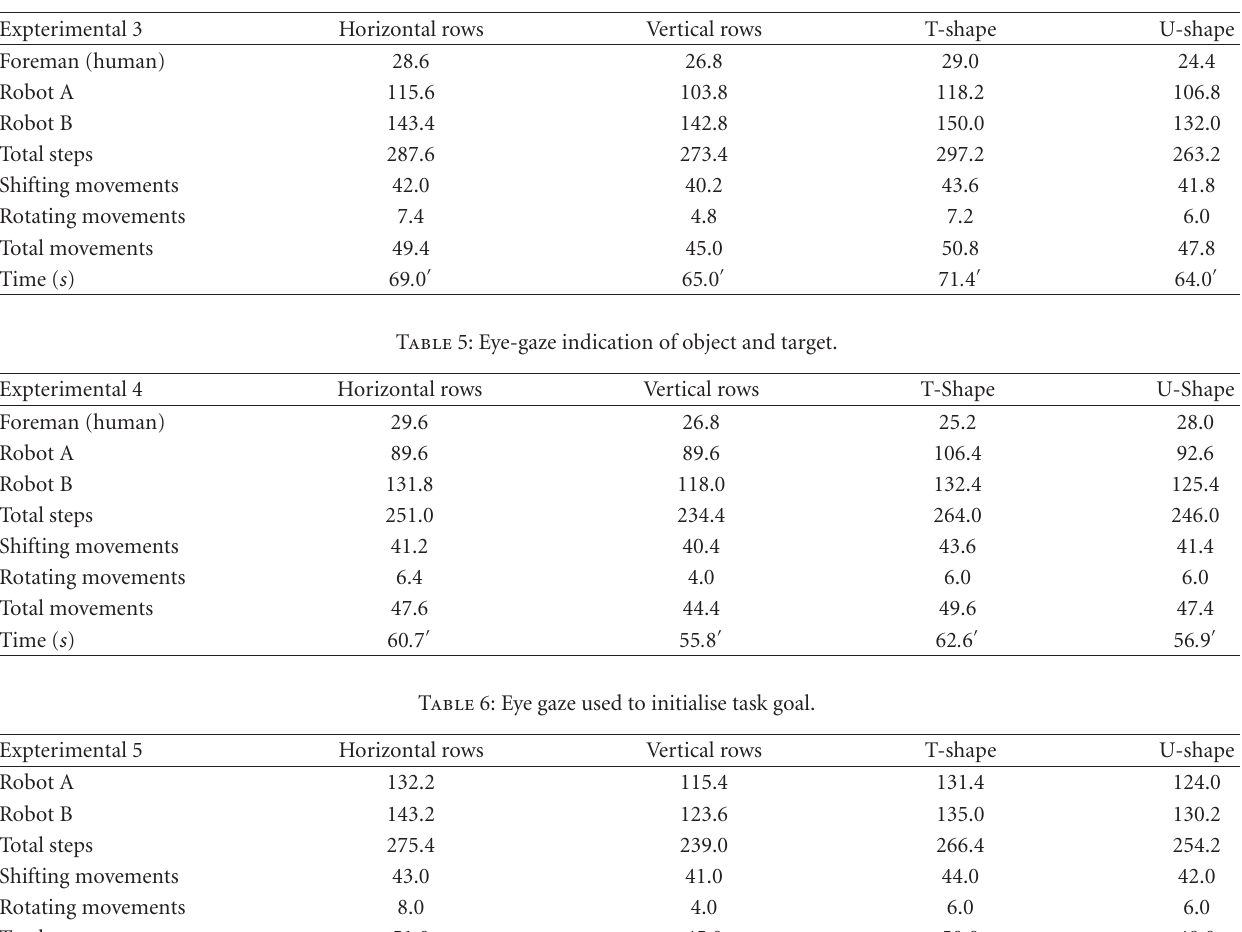
Table 4: Human and assistant start task, robots finish.